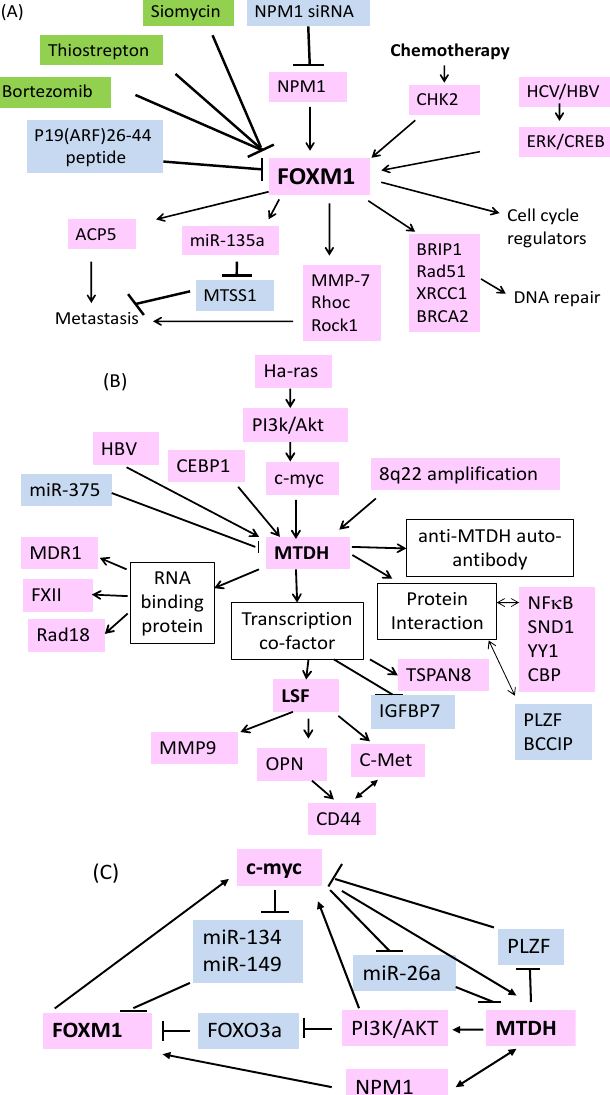
Figure 1. Mechanisms regulating the overexpression of FOXM1 (Forkhead box M1), MTDH (metadherin) and downstream effectors and strategies used to target FOXM1 in HCC (Hepatocellular carcinoma). ( A ) Thiazole compounds siomycin and thiostrepton, proteasome inhibitors (highlighted in green boxes), ARF peptides and NPM1 siRNA (highlighted in blue boxes) can reduce the expression of FOXM1. Chemotherapy can increase FOXM1 stability via CHK2. HBV/HCV can increase FOXM1 through ERK/CREB. Up-regulated FOXM1 subsequently controls cell cycle transition, DNA repair and metastasis via positive (pink boxes) or negative (blue boxes) regulating downstream effectors. ( B ) Multiple mechanisms including chromosome amplification at 8q22, Ras, PI3K/Akt, myc activation, increased CEBP1, reduced miR-375, and HBV infection can cause up-regulation of MTDH. Increased MTDH can regulate various downstream effectors to control drug resistance and metastasis via RNA or protein interactions. Increased expression of anti-MTDH auto-antibody, TSPAN8 and reduced expression of IGFBP7 in HCC patient blood might be used as poor prognosis biomarker. ( C ) Multiple feedback loops are involved in the expression regulation of MTDH, FOXM1 and c-myc in